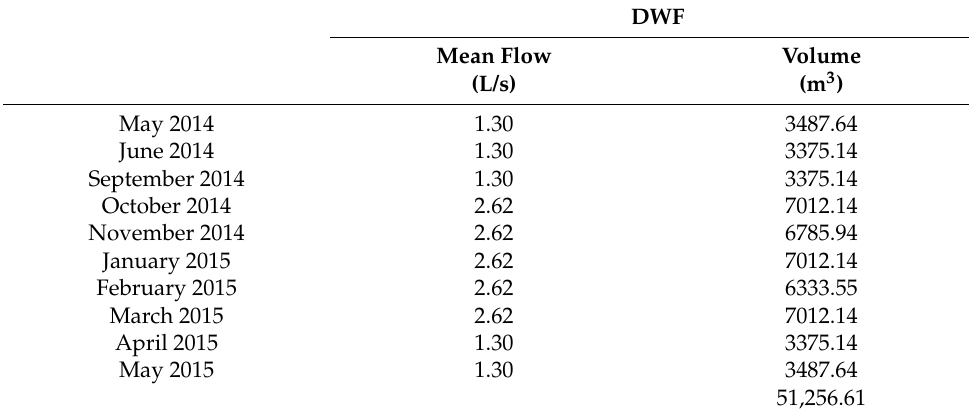
Table 2. Representative flow of a rainless period (DWF) for dry and wet seasons: monthly mean flow and respective total monthly volumes.